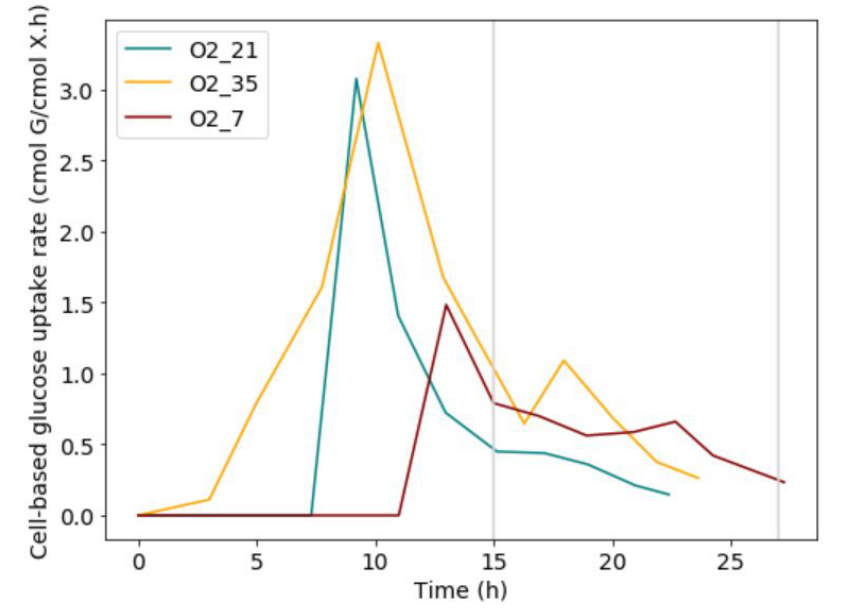
Figure 5. Glucose uptake rates increase during the lag phase and exponential growth, but stabilize during mass transfer limited growth. It is hypothesised that malic acid is formed during exponential growth and the start of mass transfer limited growth to counteract the excess